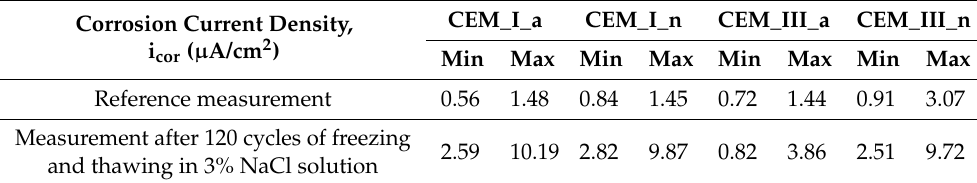
Table 3. Minimum and maximum values of corrosion current density obtained from measurements before and after cycles of freezing and thawing specimens in a 3% NaCl